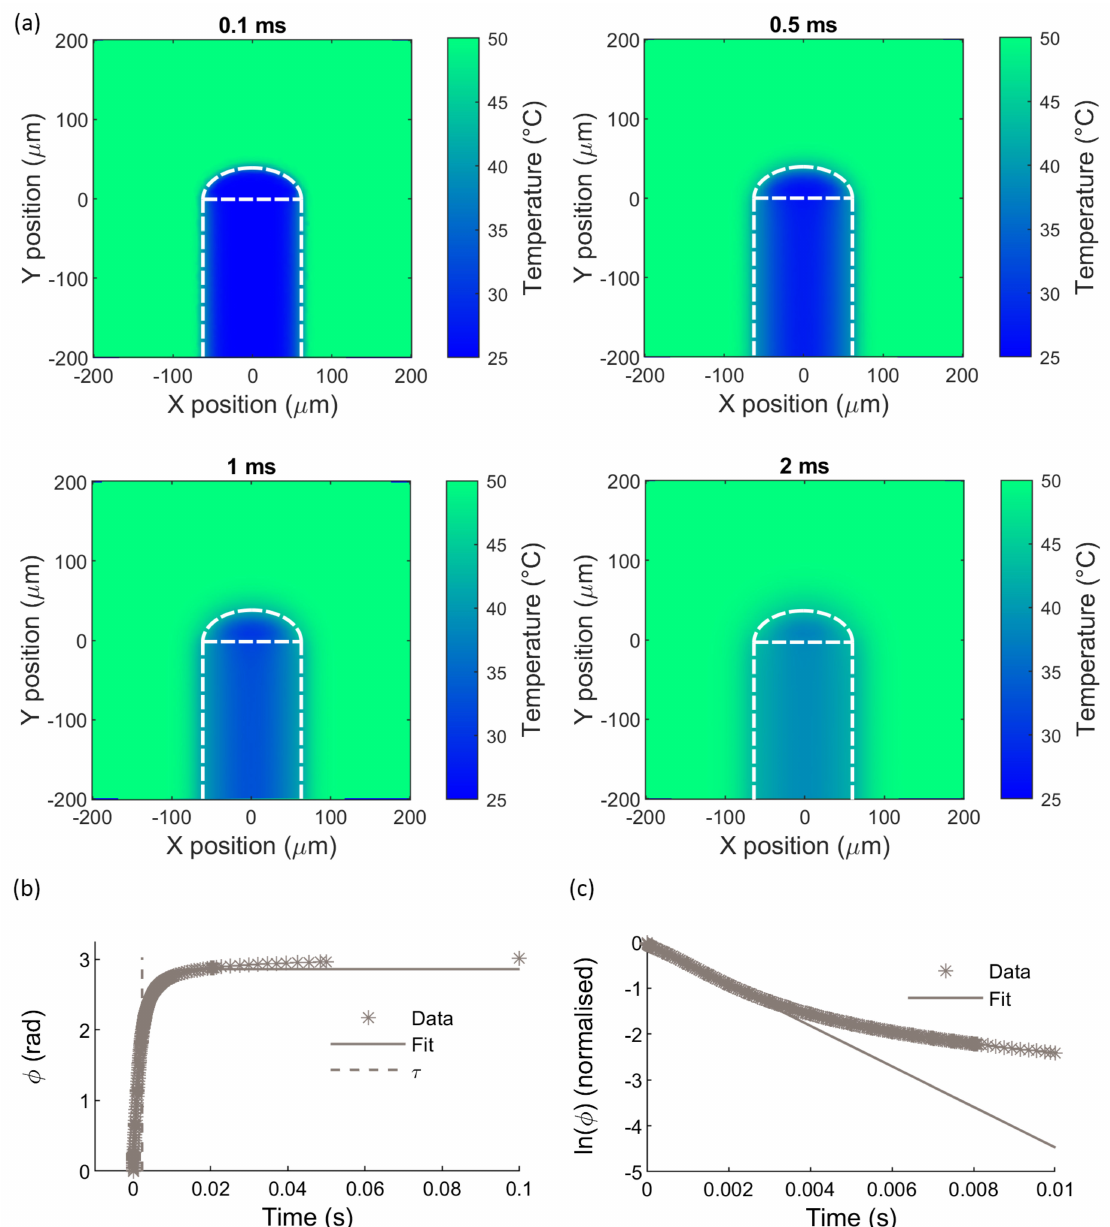
Figure 6. ( a ) Temperature maps in the x - y plane at z = 0, at different time points in the temperature step simulation. The surrounding medium had an initial temperature of 50 ◦ C, and the dome and fibre were at an initial temperature of 25 ◦ C. ( b ) Sensor signal versus time, in response to the step temperature change, as obtained from the simulated temperature distributions. The solid line indicates the exponential fit, and the dashed vertical line indicates the time constant obtained from the fit. Only data for t ≤ 0.1 s are shown, to show the initial rapid increase in the sensor signal more clearly. ( c ) Plot comparing the natural logarithm of the simulated sensor signal and fit, for t ≤ 0.01